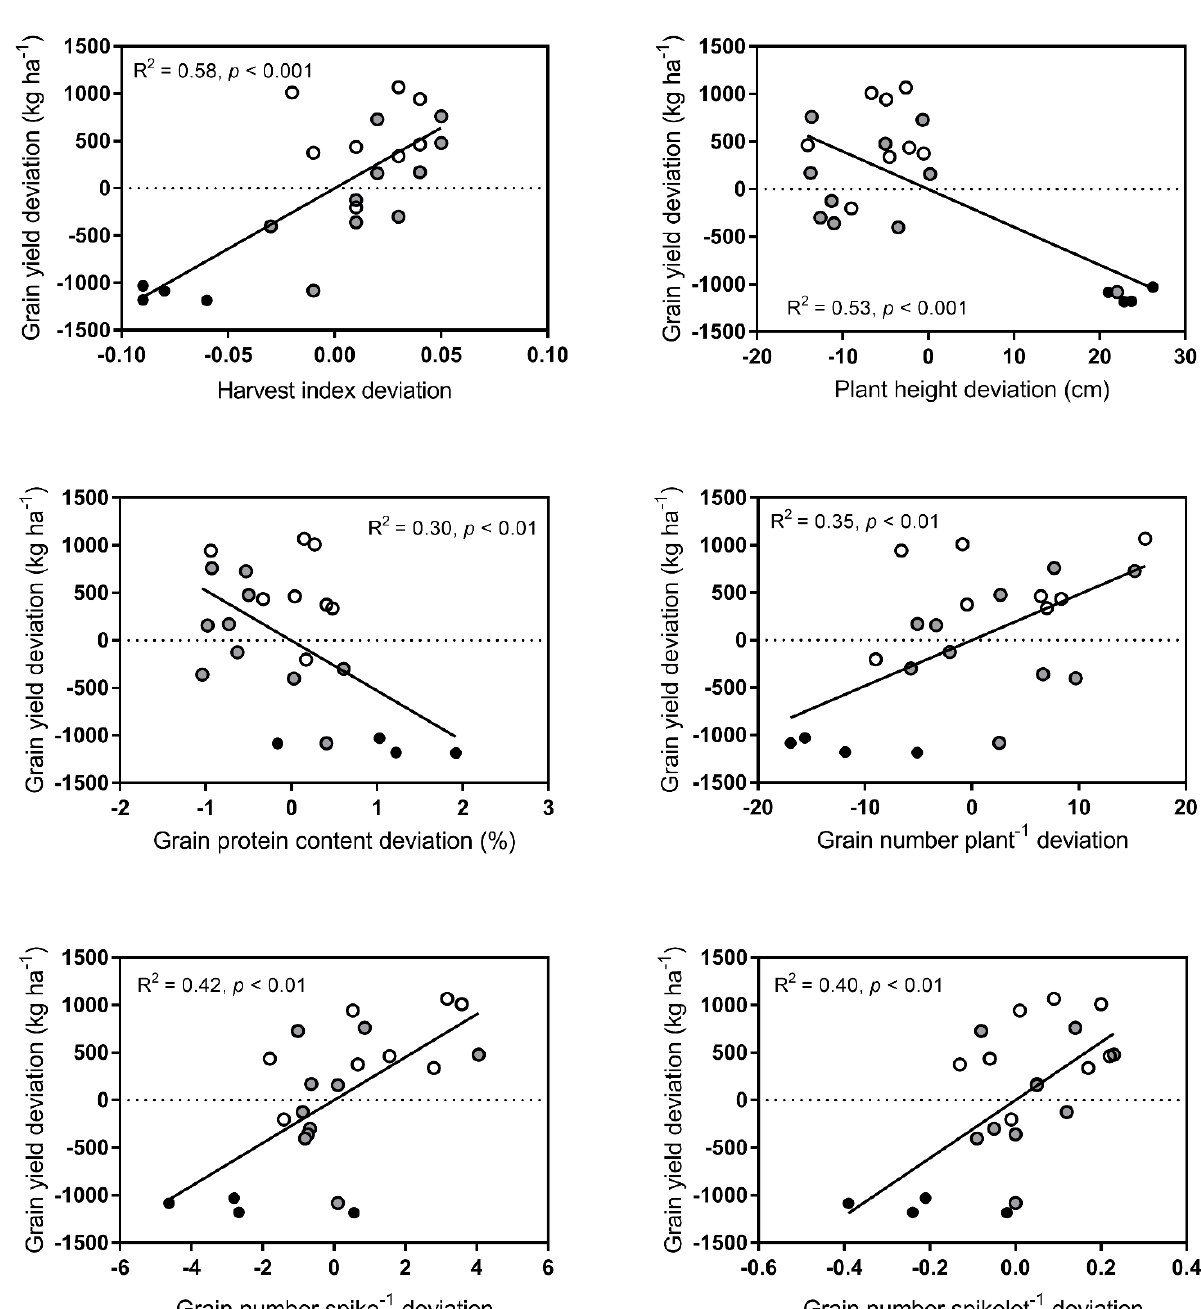
Figure 5. Regression analyses between the grain yield deviation and harvest index, plant height, grain protein content and grain number deviations. Each point represents the average of trait deviation for each cultivar with respect to the mean values in each experiment (Cabildo and Pieres in 2014 and Barrow in 2017). Black, grey and white points correspond to the cultivars released in the periods 1934–1979, 1980–1999 and 2000–2015, respectively. Horizontal dotted lines represent the mean value of grain yield for each experiment.